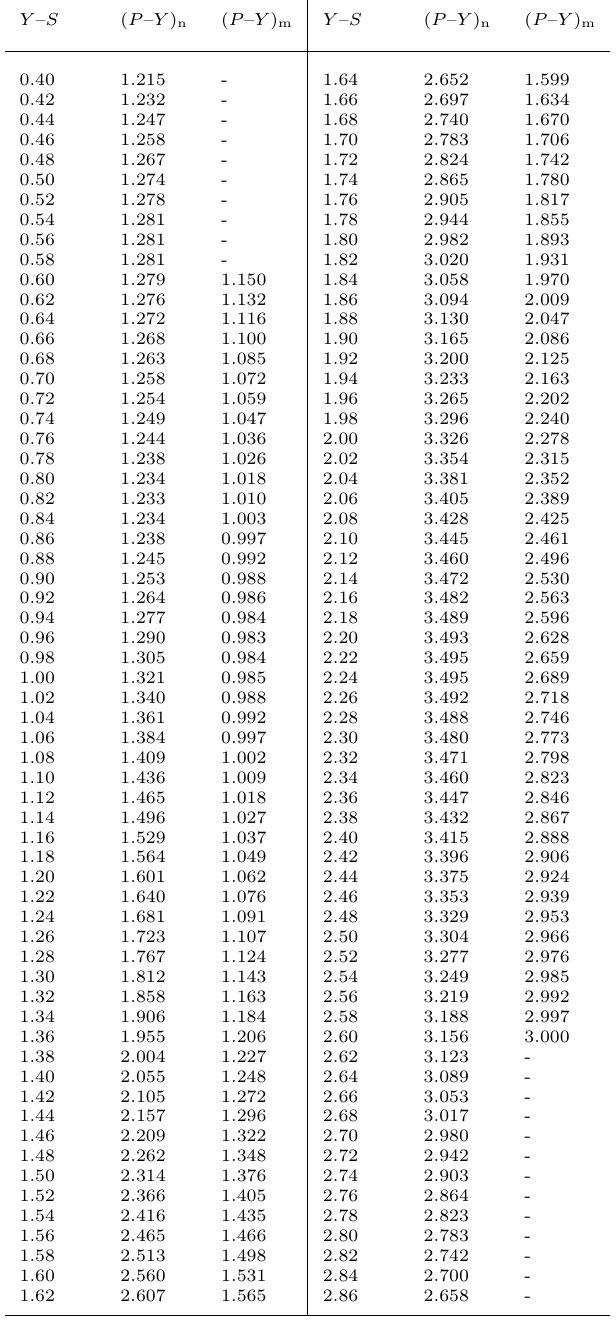
Table A2 . P – Y vs. Y – S relations for luminosity class